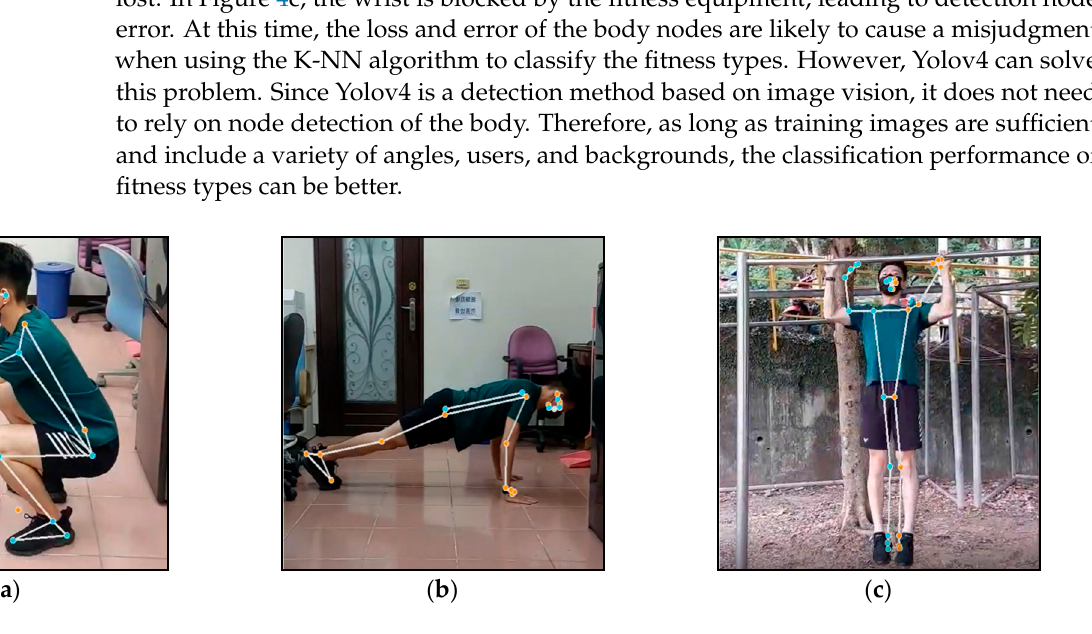
Figure 4. Node missing on Mediapipe detection, ( a ) squat missing node, ( b ) push-up missing node, and ( c ) pull-up missing node.